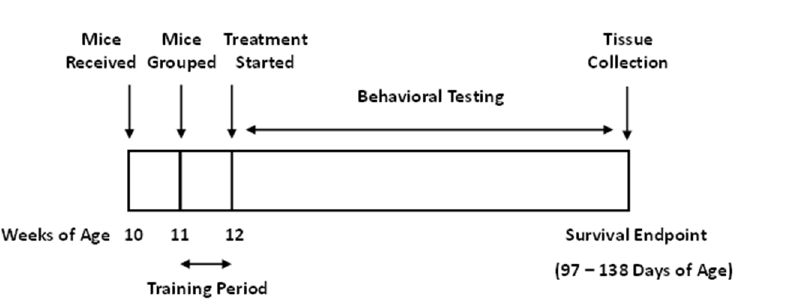
Figure 2. Experimental design for survival study. At week 11, behavioral training was initiated. At week 12, treatments were started. Table 1. Experimental treatment groups.